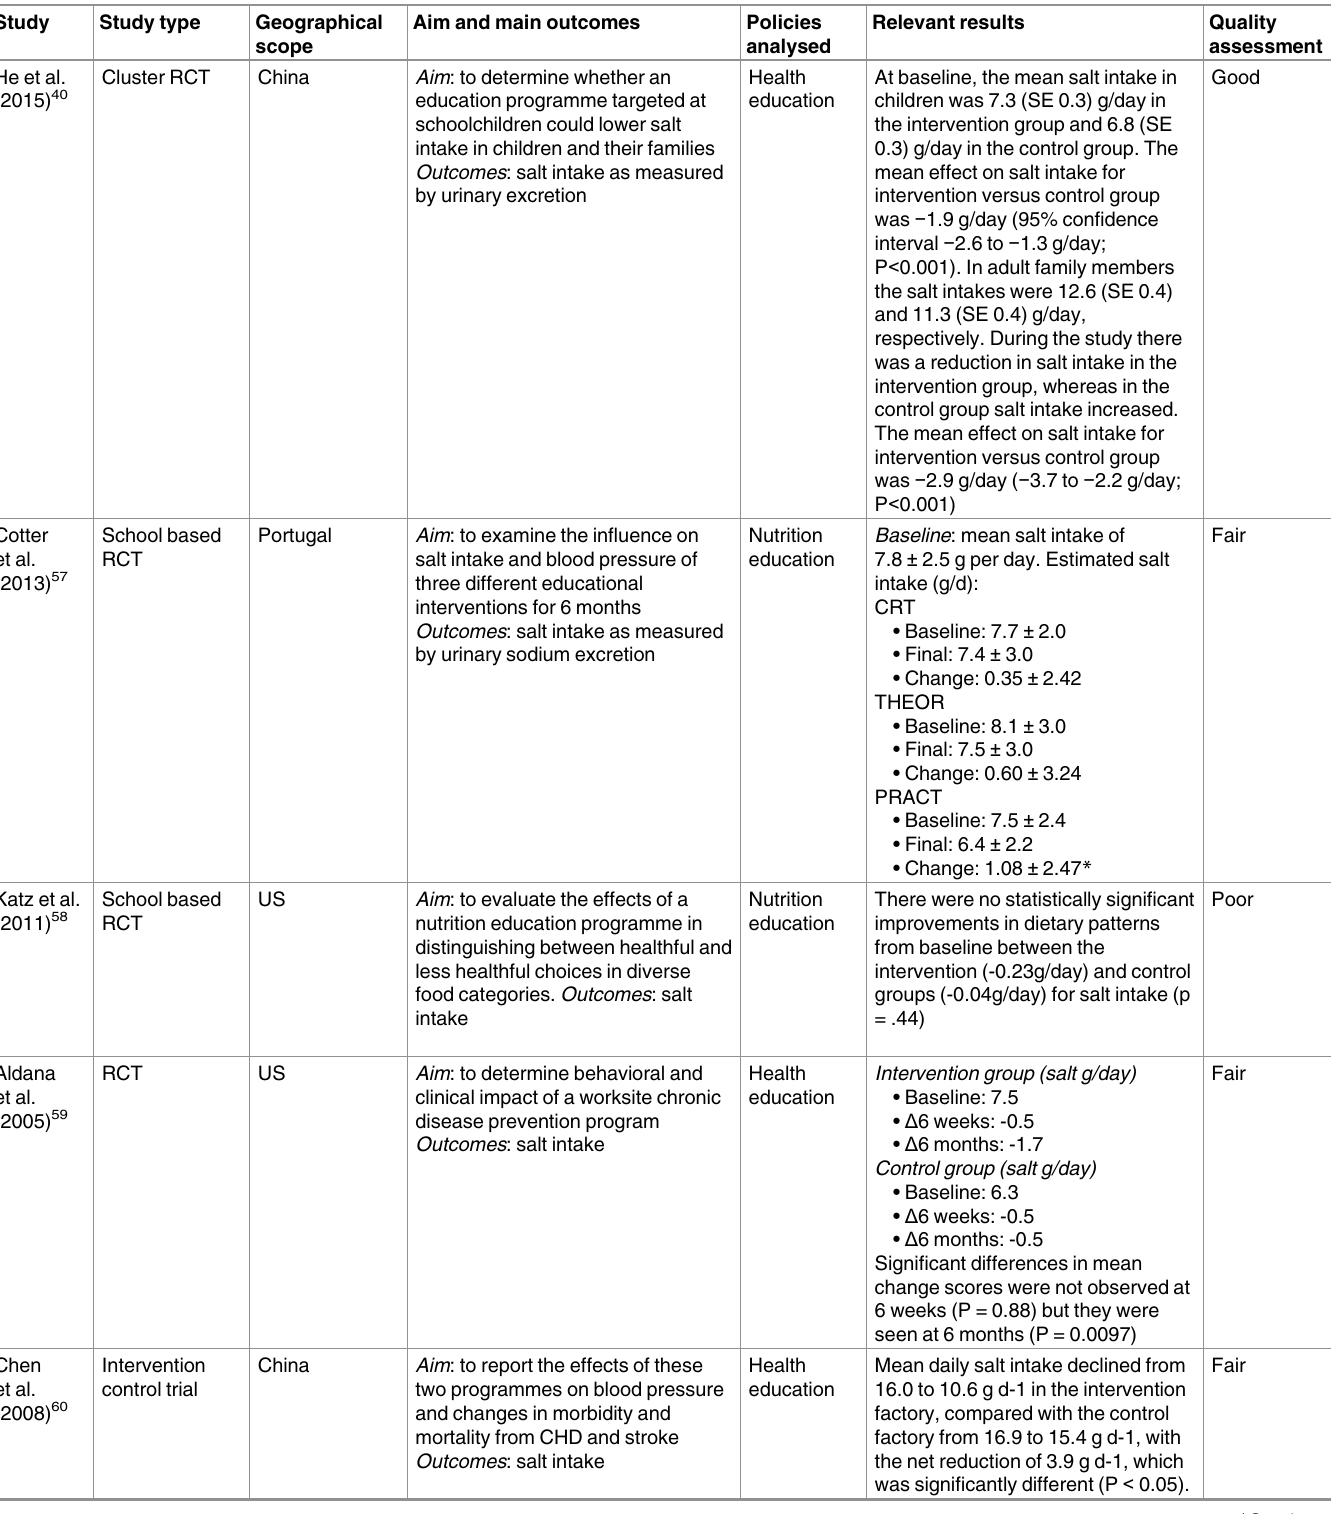
Table 3. Dietary counselling